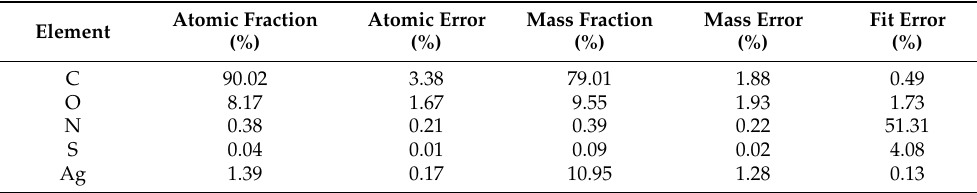
Table 1. Element analysis of the spectra from Area #1 (Figure 3).